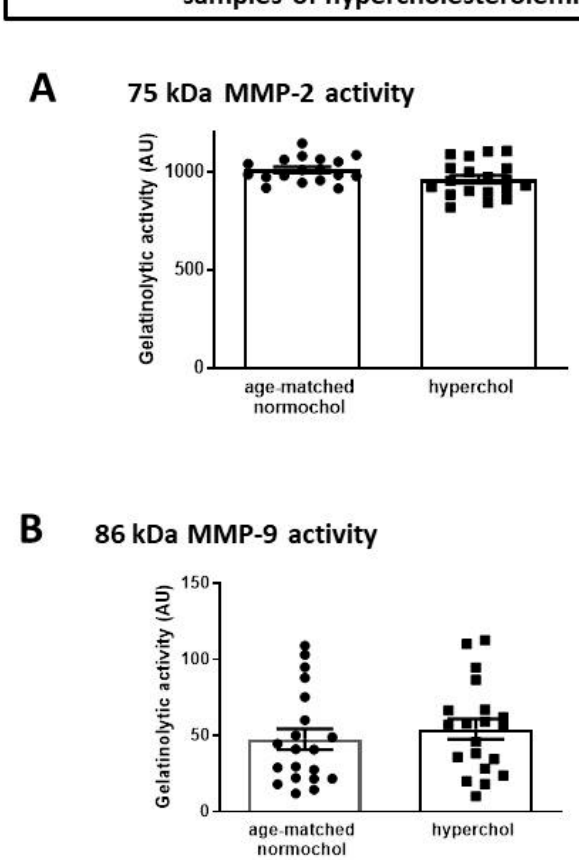
Figure 5. Gelatinolytic activity of ( A ) MMP-2 and ( B ) MMP-9. AU: arbitrary units.